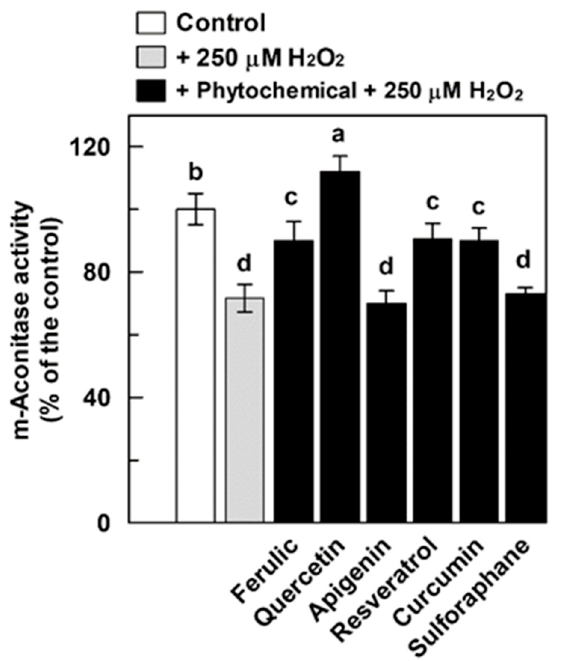
Figure 5. Protective effect of different phytochemicals on m-aconitase activity treated with 250 µM H 2 O 2 . Measurements were carried out as described in Methods by incubating m-aconitase (250 µg) for 10 min with different phytochemicals applied at 150 µM (75 µM in the case of resveratrol) and for 15 min with H 2 O 2 . Activity values are expressed as a percentage of the control (i.e., the reaction measured at time 0 in the absence of both H 2 O 2 and phytochemicals) and reported as the mean value ± SD ( n = 3). Means with no lowercase letter a–d in common are statistically different at a 0.05 p level of significance, according to the post hoc Duncan’s test, following ANOVA. Means with at least one common lowercase letter are not significantly different at p ≤ 0.05. In this set of experiments, m-aconitase activity under control conditions was equal to 18 ± 1 (SD, n = 3) nmol ∙ min − 1 ∙ mg − 1 of protein.